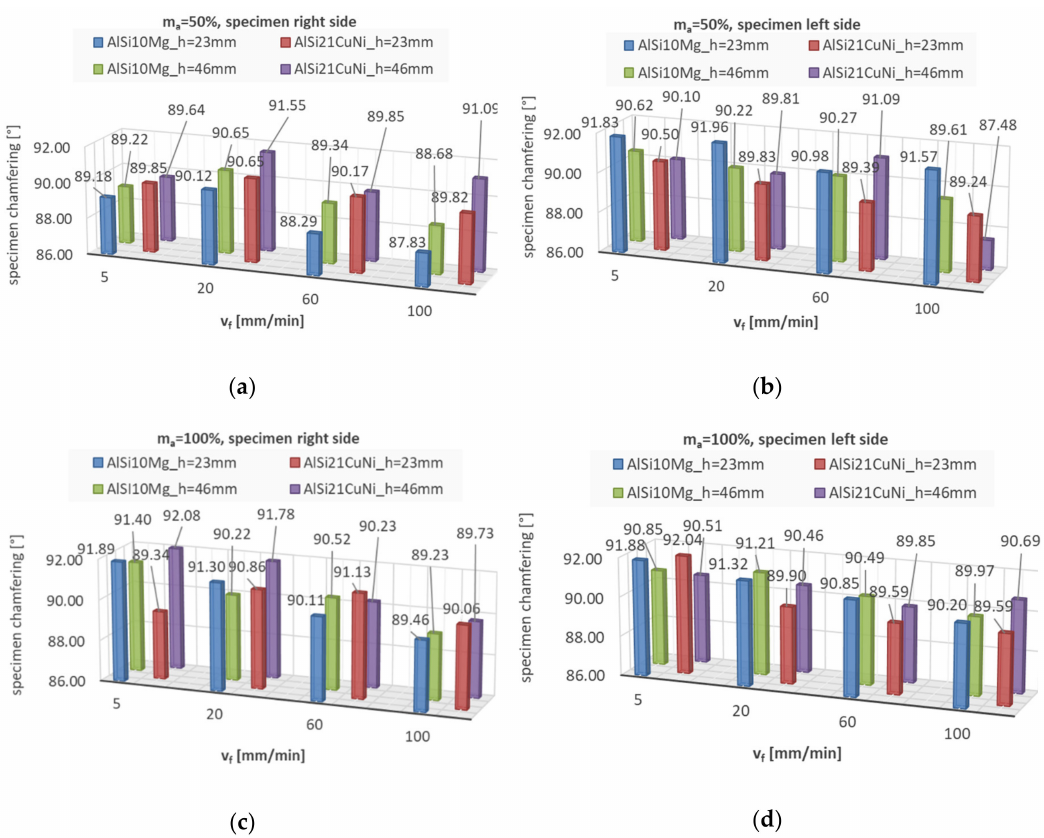
Figure 7. Specimen chamfering by abrasive waterjet machining depending on the side of impact and abrasive flow rate (m a = 50% and 100%): ( a ) right side specimen m a = 50%, ( b ) left side specimen m a = 50%, ( c ) right side specimen m a = 100%, ( d ) left side specimen m a = 100%.